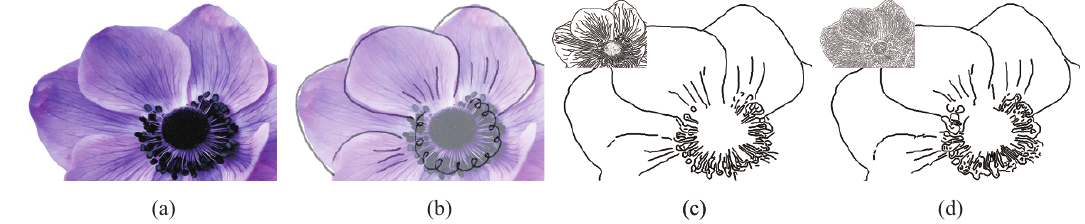
Fig. 1 Given an input image (a) along with a few scribbles by the user (b), our system automatically extracts a concise line abstraction with coherence and structure lines depicting the edges of the petals and the shapes of the pistils (c, d). Note that our system can adaptively produce highly detailed line drawings using different image filters (see